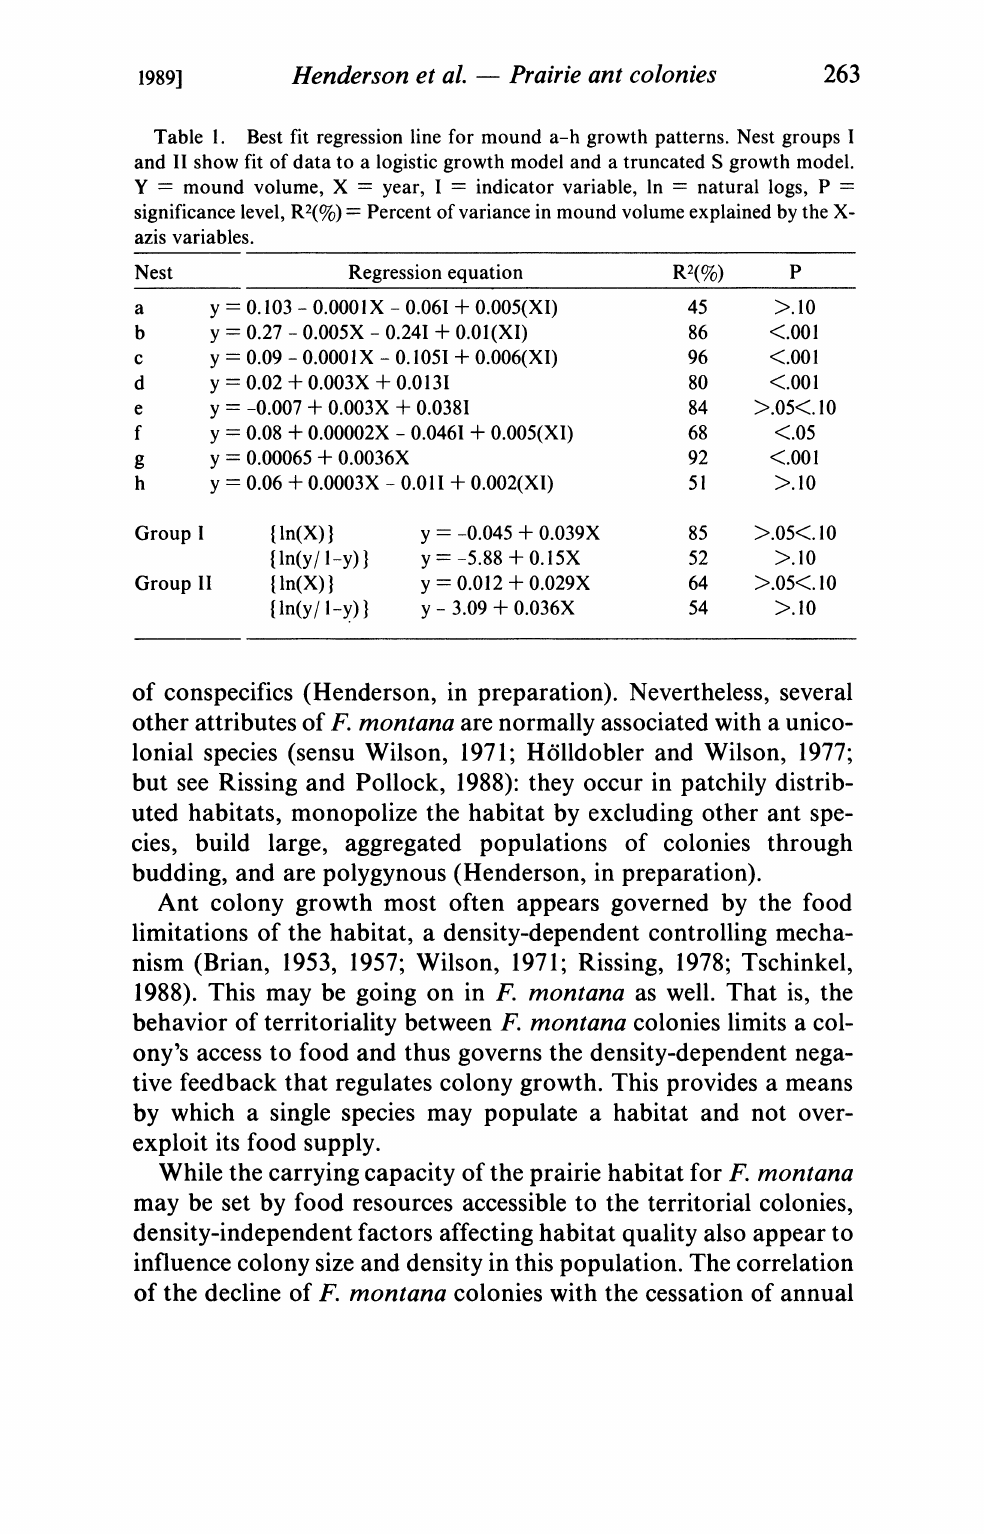
Table 1. Best fit regression line for mound a-h growth patterns. Nest groups and II show fit of data to a logistic growth model and a truncated S growth model. Y mound volume, X year, indicator variable, In natural logs, P significance level, R2(%) Percent of variance in mound volume explained by the X- azis variables.